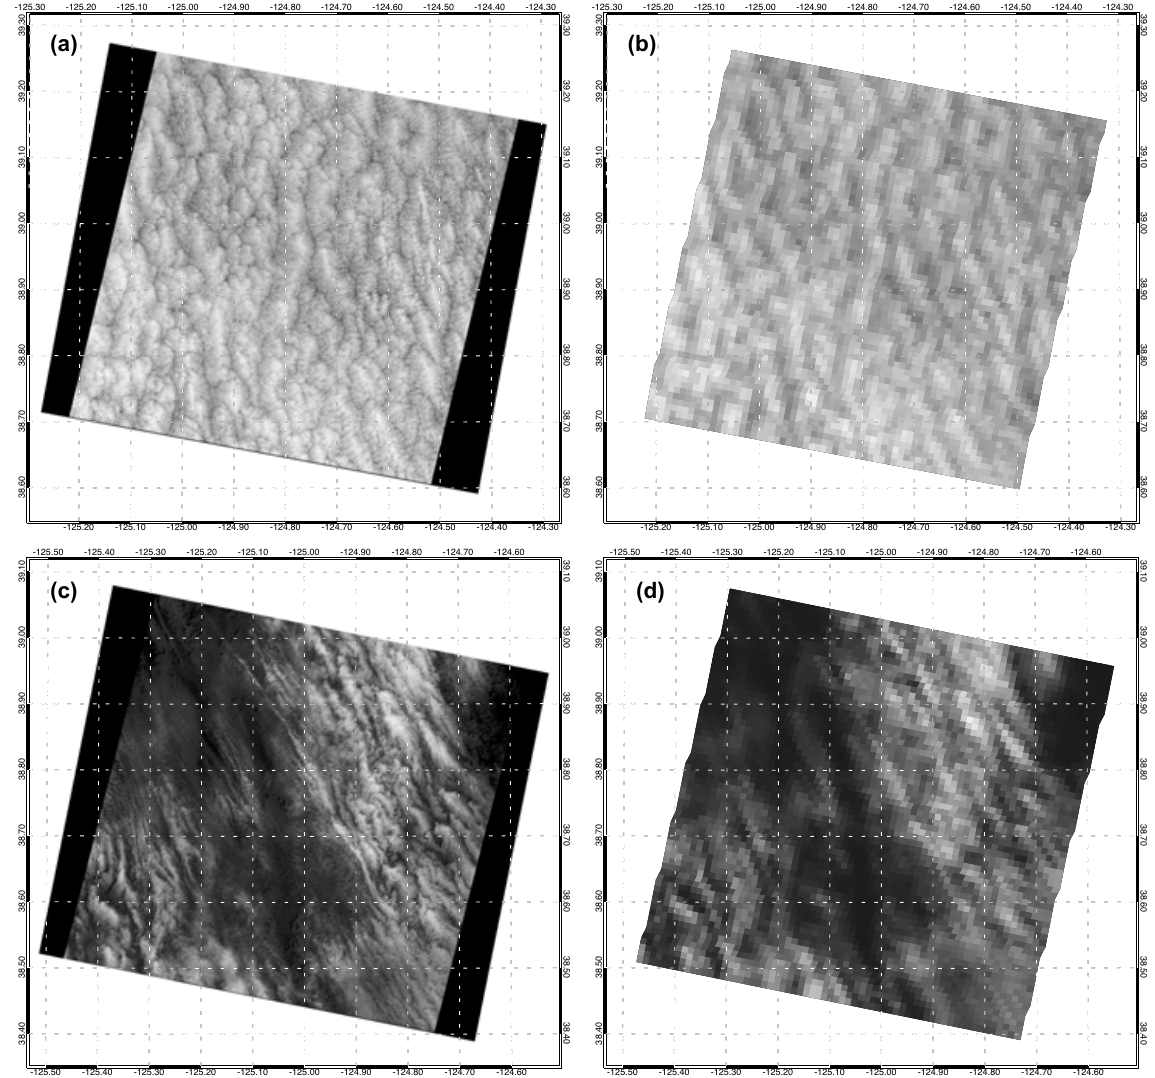
Figure 6. (a) Single-band grayscale image of band 3N reflectances sampled by ASTER on 13 May 2003 off the coast of California (scene C14). (b) Same as (a) but from band 2 reflectances sampled by MODIS. (c) – (d) Same as (a) – (b) but sampled on 10 June 2005 (scene